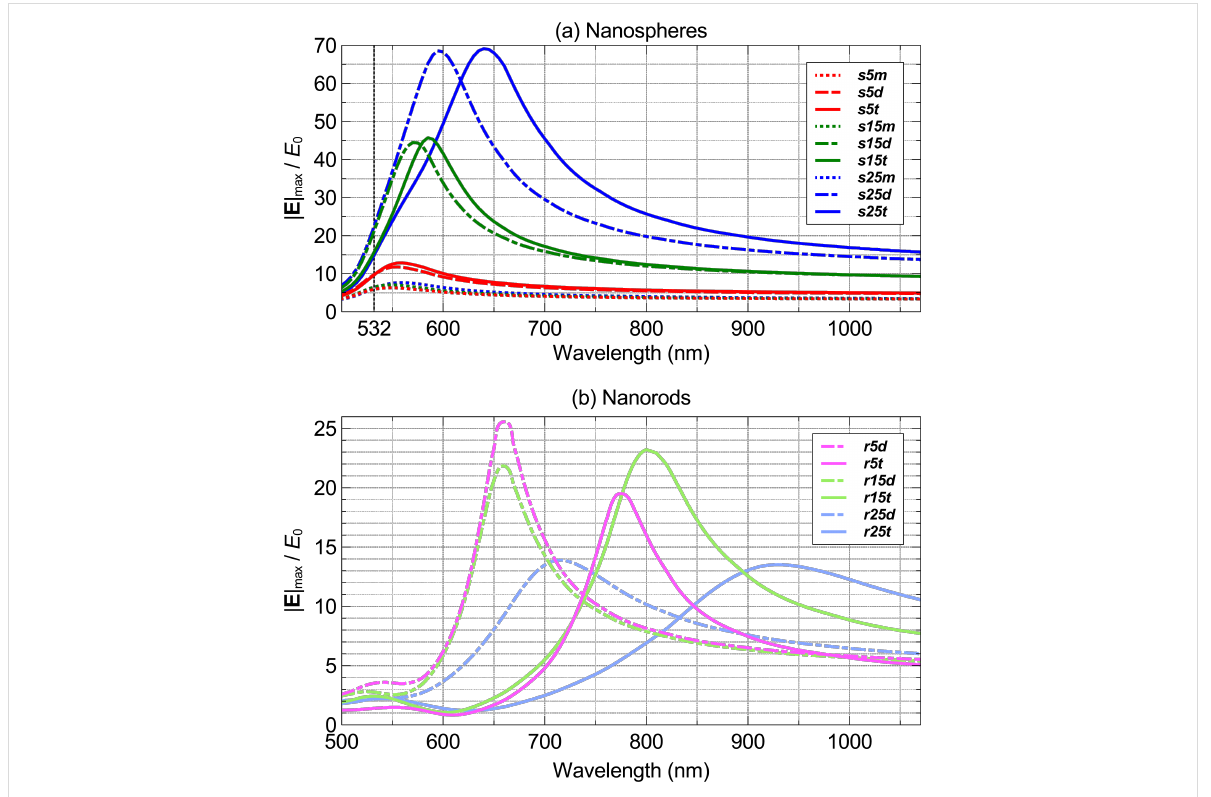
Figure 3: Maximum near-field enhancement, | E | max / E 0 , located at the hot zones of the assemblies or poles of the monomers (see Figure 4a–d). The dimensions of the particles are given in Table 1.